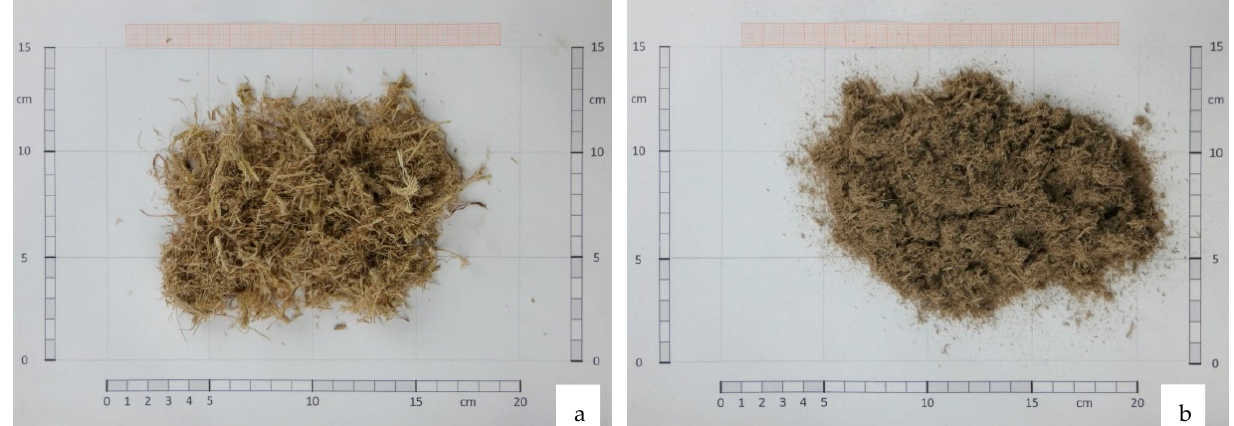
Figure 9. Grapevine fibre ( a ) and poplar fibre ( b ) extruded at 20 mm aperture setting.